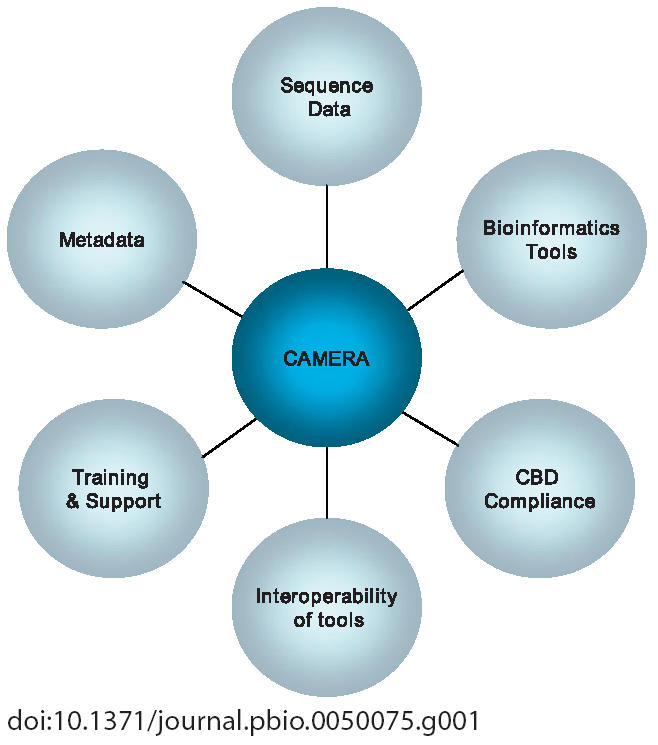
Schematic of Intended Core Functions of the CAMERA ProjectCBD, Convention on Biological Diversity.